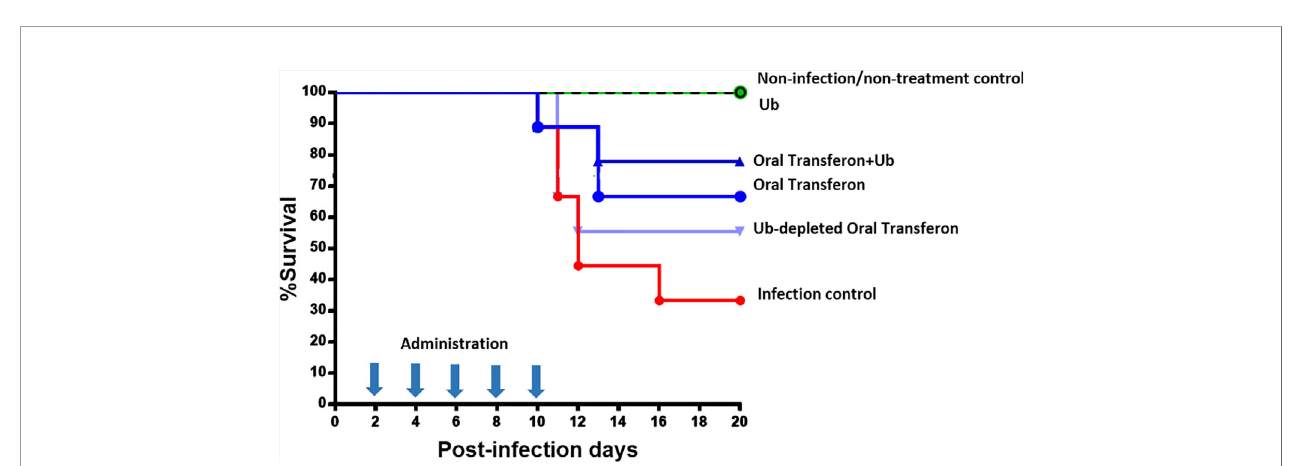
FIGURE 9 | Effect of Transferon and Ub in the HSV-1 infection murine model. HSV-1 infected mice were treated with Transferon (0.50 m g/200 m L), monomeric Ub (0.75 m g/200 m L), “ Transferon Oral ” + monomeric Ub, or monomeric Ub-depleted Transferon ( ≈ 0.50 m g/200 m L). The addition of Ub to Transferon increased (77.7 vs. 66.6%), and the removal of Ub decreased (55.5 vs. 66.6%) the %survival respect to the group treated only with Transferon. Ub treated group showed 100% of